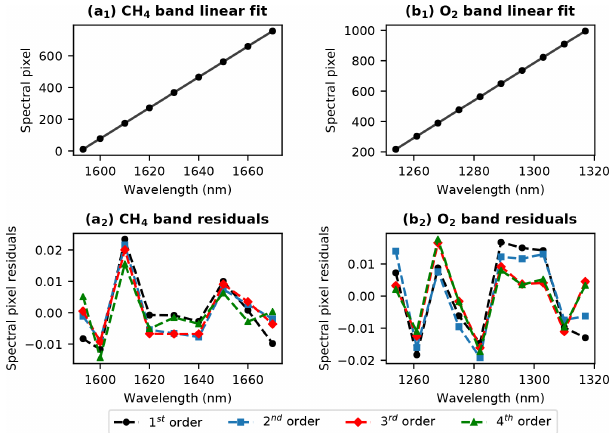
Figure 16. Wavelength registration fitting results for CH 4 (a) and O 2 (b) bands, demonstrated for spatial pixel 600. Top panels show a linear fit to the data, which was determined to be the optimal poly- nomial order by AIC and BIC. Residuals from first- through fourth- order polynomial fits are given in the bottom